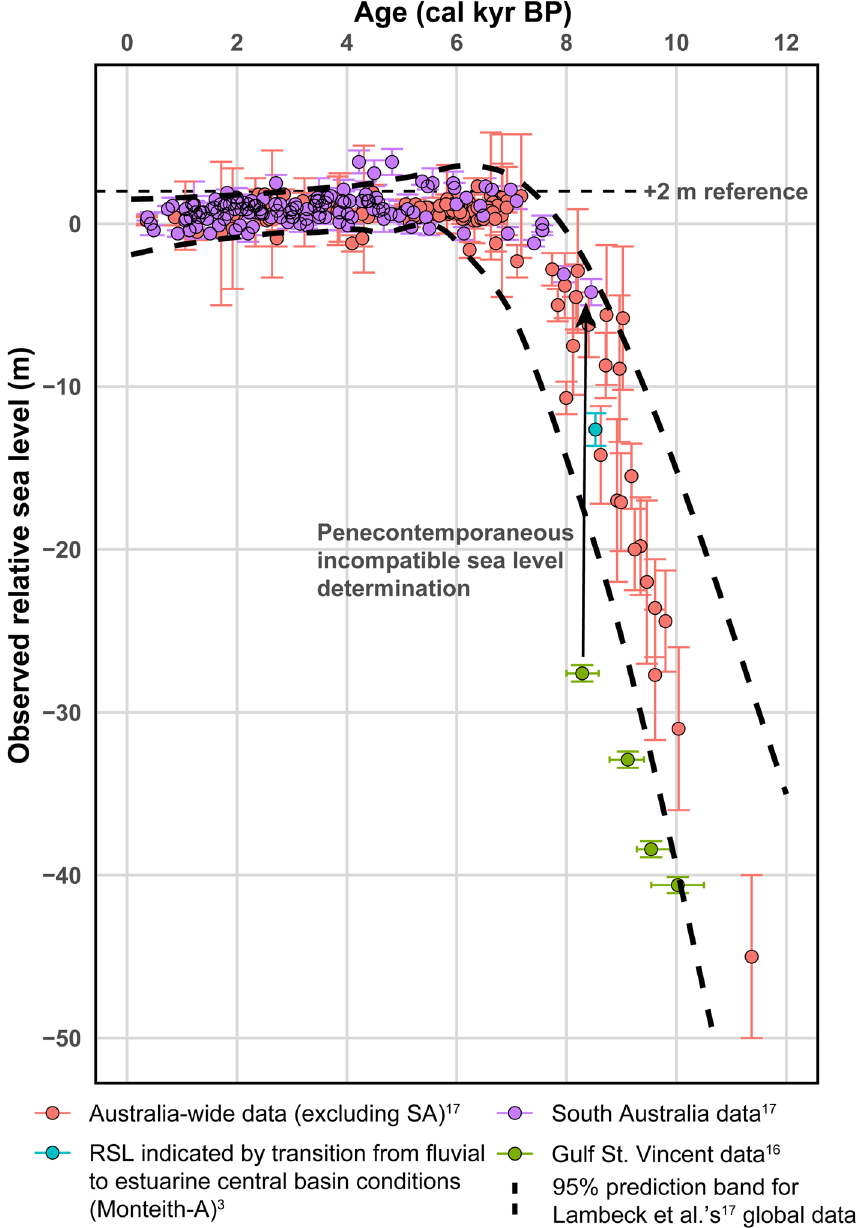
Figure 1. Observed relative sea levels during the Holocene. Australia-wide (excluding South Australia; n = 182), South Australia (n = 129), and global (n = 968) data are sourced from Lambeck et al. 17 . Sea level data from Gulf St. Vincent (n = 4; intertidal indicators only) 16 were calibrated using the Marine20 radiocarbon age calibration curve 20 using a ΔR of 84 yr and a standard deviation of 59 yr (as performed by Tibby et al. 1 ) in CALIB 8.1 21 . 2σ age uncertainties for the Gulf St. Vincent data are included as horizontal error bars. The modelled 2σ age uncertainty (197 yr) for the Monteith-A transition is obscured by the plotted point. Lambeck et al. 17 statistically incorporated age uncertainties into the elevation uncertainties which are included here. Upper and lower 95% prediction limits for global Holocene RSL data (plotted as black dashed lines) were calculated through locally weighted regression smoothing (LOESS) using R 4.0.4 24 and the msir (v1.3.3 25 ) package. The Gulf St. Vincent determinations of sea level between -28 m to -33 m between 8 cal kyr BP and 9 cal kyr BP are incompatible with the penecontemporaneous South Australian determinations of sea level between −2 m and −4 m at 8–8.4 cal kyr BP (see arrow). The older and deeper observations differ significantly from global observations and were excluded from the South Australian dataset by Lambeck et al. 17 as “observations providing only limiting